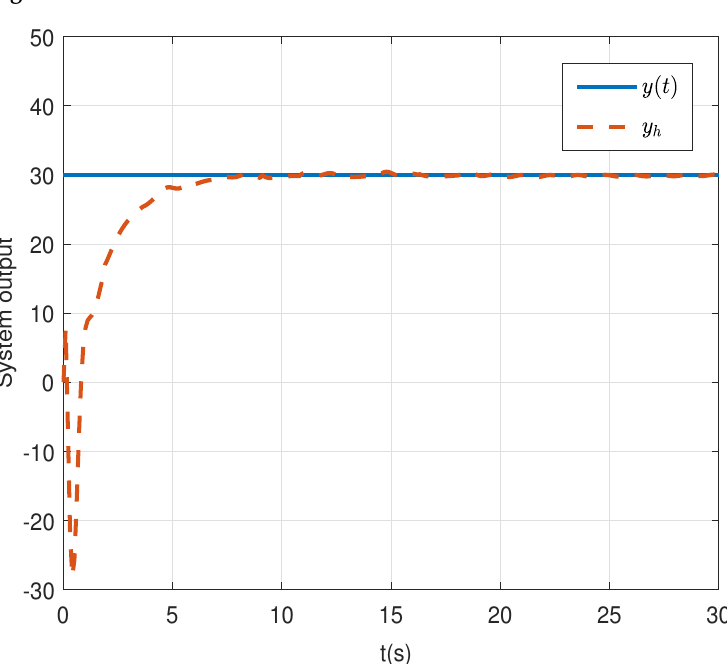
Figure 3. Disturbance and its estimation.